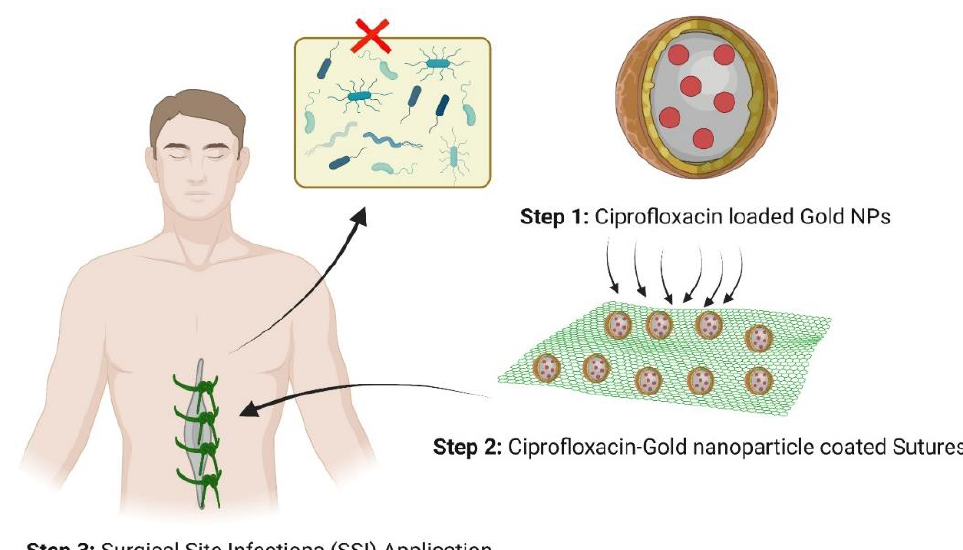
Figure 1. Schematic representation of biocompatible ciprofloxacin–gold-nanoparticle-coated sutures for surgical site